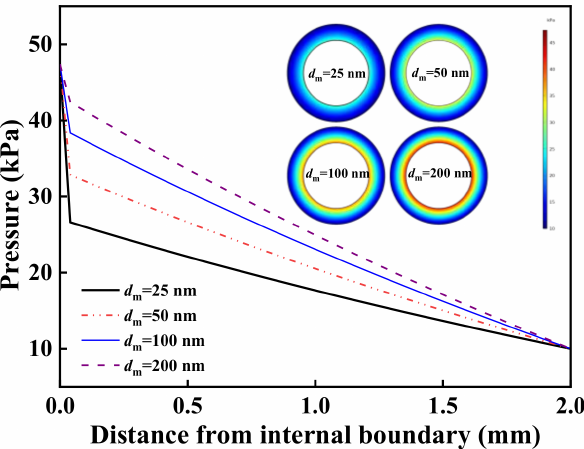
Figure 4. Cross-sectional pressure distribution of various asymmetric membranes (the thickness of the top layer was 40 µ m, the pore size of the support layer was 1.0 µ